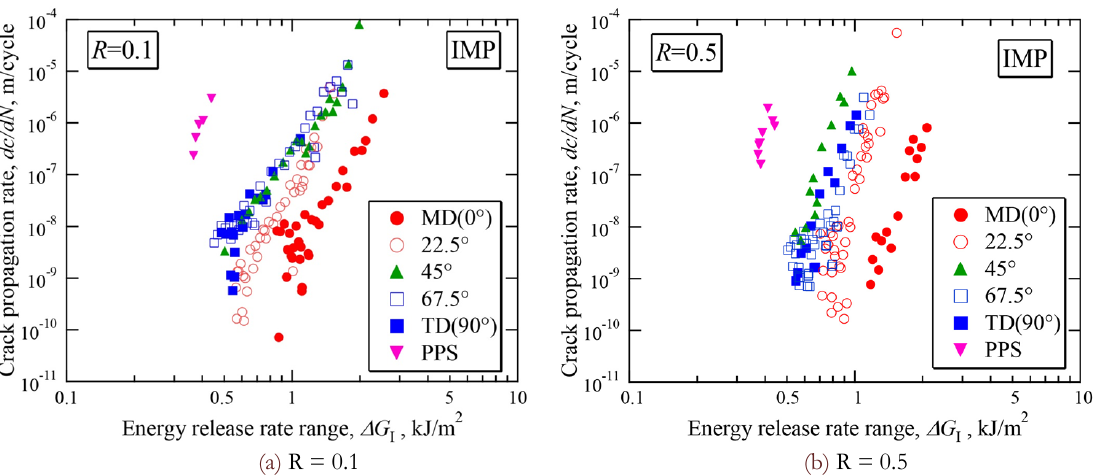
Figure 7: Crack propagation rate correlated to the range of mode I energy release rate.